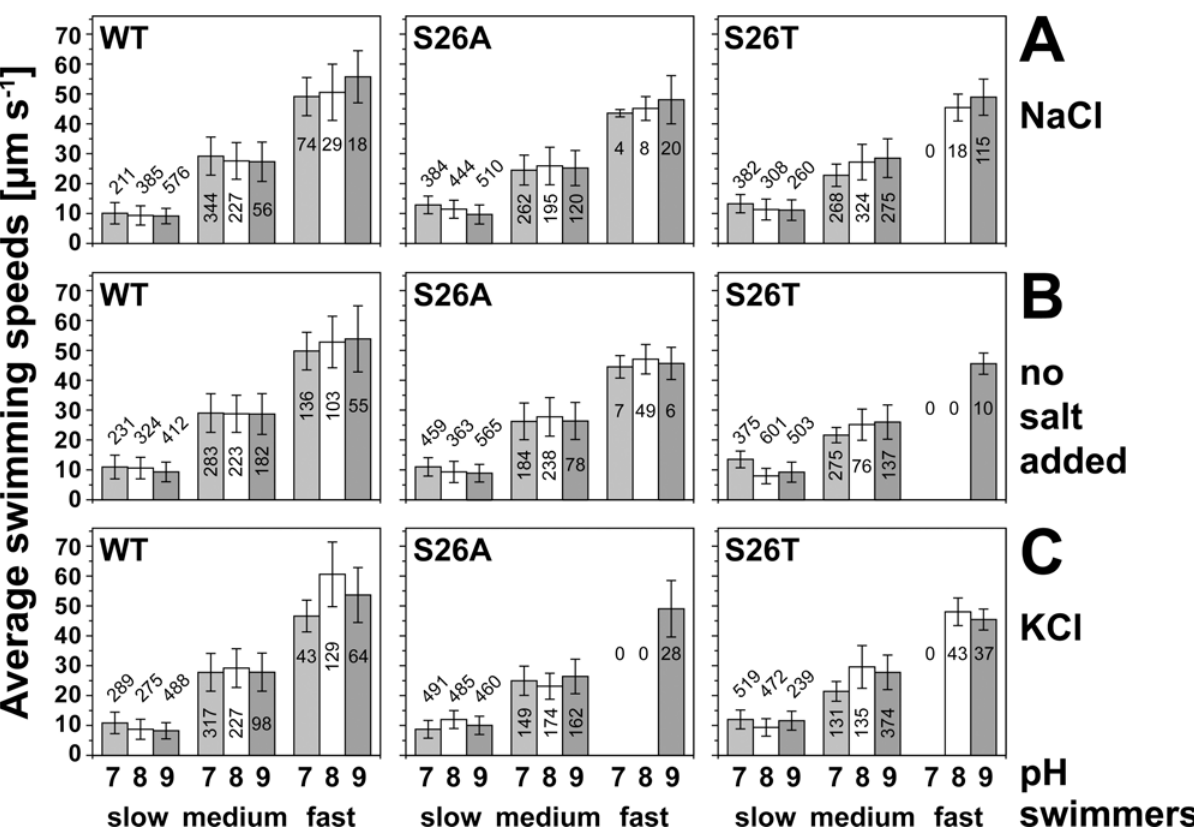
Fig 6. Influence of pH and salt condition on the swimming speeds of V . cholerae Δ pomAB cells overproducing His 6 -PomA together with PomB-Strep, PomB-S26A-Strep, or PomB-S26T-Strep. Tracks were recorded in different LB media adjusted with Tris to pH 7.0 (light grey bars), pH 8.0 (white bars), or pH 9.0 (dark grey bars). A: LB-Na + ; B: no salt added, with residual concentrations of 11 mM Na + and 12 mM K + ; C: LB-K + . Tracking results of individual cells were assigned to three main classes of velocities ( “ slow ” , “ medium ” and “ fast ” ). The numbers in the bars represent the number of tracks recorded under the specified condition. The mean values and standard deviations of velocities are presented. Minimum, median and maximum values are given in the supporting information (S2 – S4